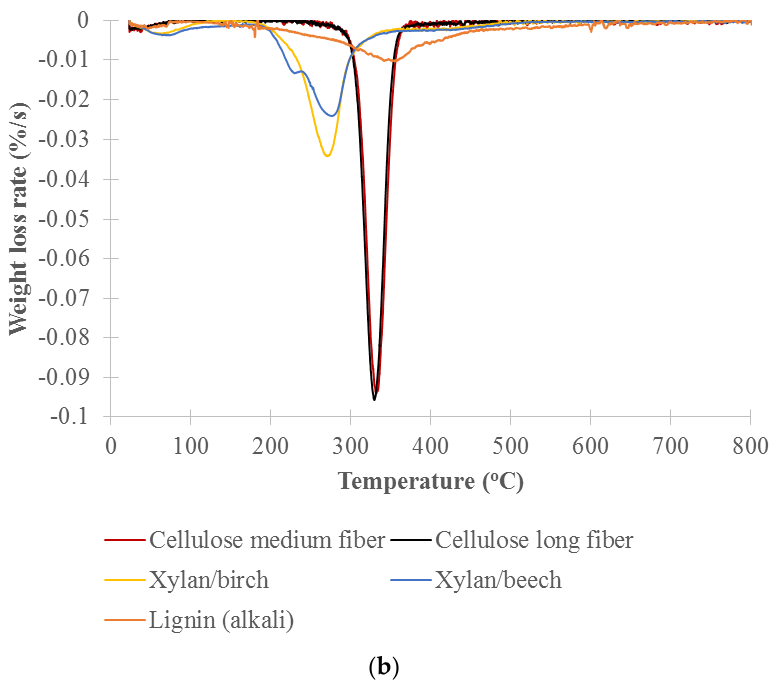
Figure 4. ( a ) Thermogravimetry (TG); ( b ) Differential thermogravimetry (DTG) curves versus temperature for the pure model components (xylan/hemicelluloses, cellulose, and lignin) of biomass cell wall components.